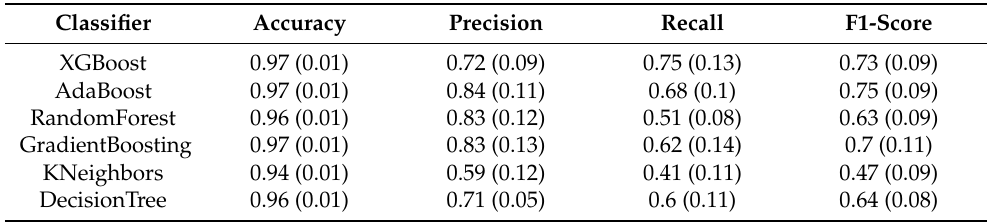
Table 8. Models’ performance for Linear Interpolation with only small packets after applying class weight (standard deviation in brackets).